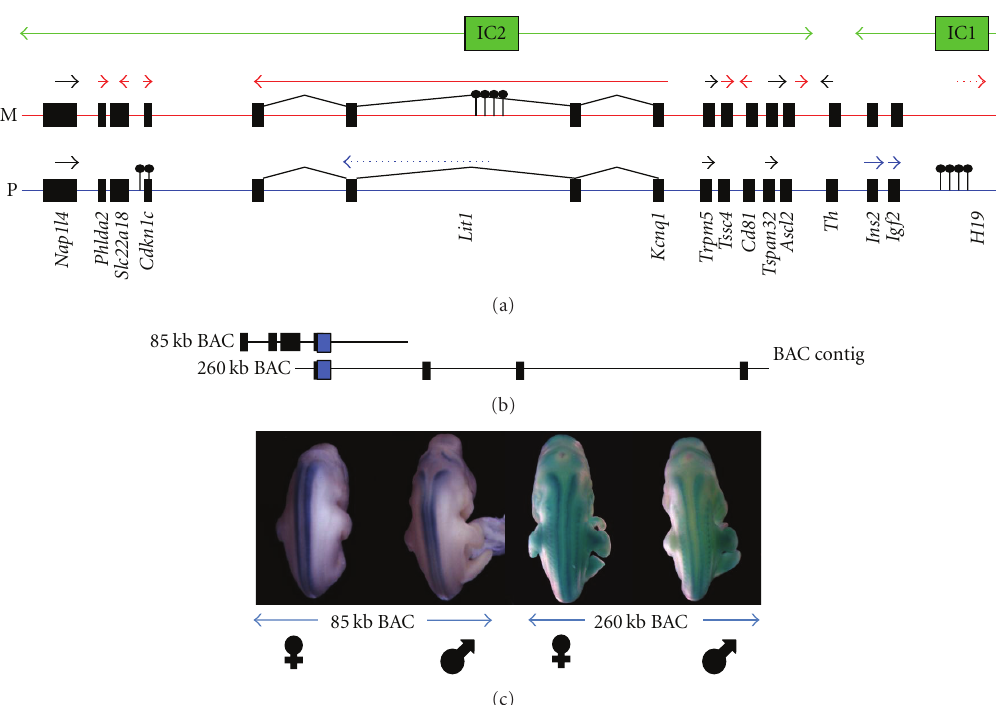
Figure 2: Mouse distal chromosome 7 contains two complex imprinted loci. (a) A diagrammatic representation of mouse distal chromosome 7 with maternal inheritance indicated in red and paternal inheritance indicated in blue. Genes are represented by the black boxes with the parent-of-origin expression indicated by either a red (maternal) or blue (paternal) arrow. Biallelic expression is indicated by a black arrow. Noncoding RNAs are represented by dashed arrows. DNA methylation is represented by the black lollypops. Green boxes indicate position of ICs whilst green doubleheaded arrows indicate the region influenced by the IC. (b) BAC clones that are used to examine expression, imprinting, and function. Blue boxes indicate the position of lacZ insertion. (c) Images of transgenic embryos inheriting the modified BACs through either the maternal or paternal germline as indicated by gender symbols below image. Expression of Cdkn1c from the BAC is revealed by lacZ reporter